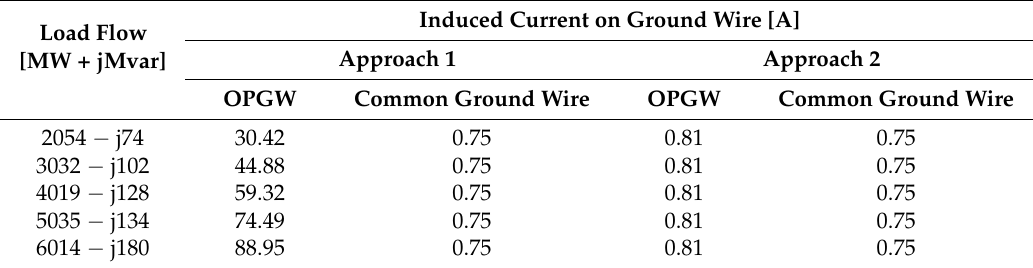
Table 5. Induced current on UHV AC overhead ground wire.